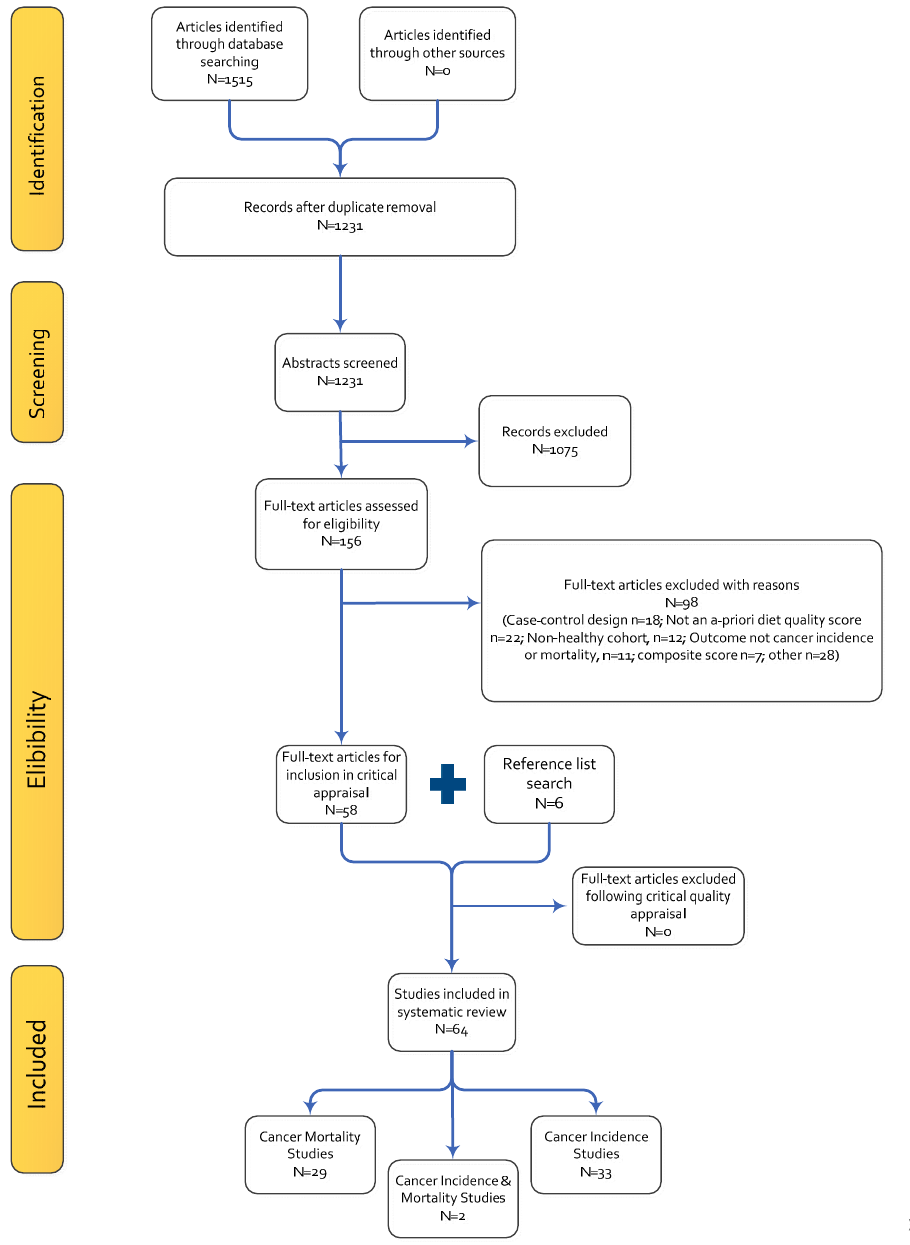
Figure 2. Flow diagram showing the method of determining studies to be included in the systematic review. Table 2. Summary of included studies.